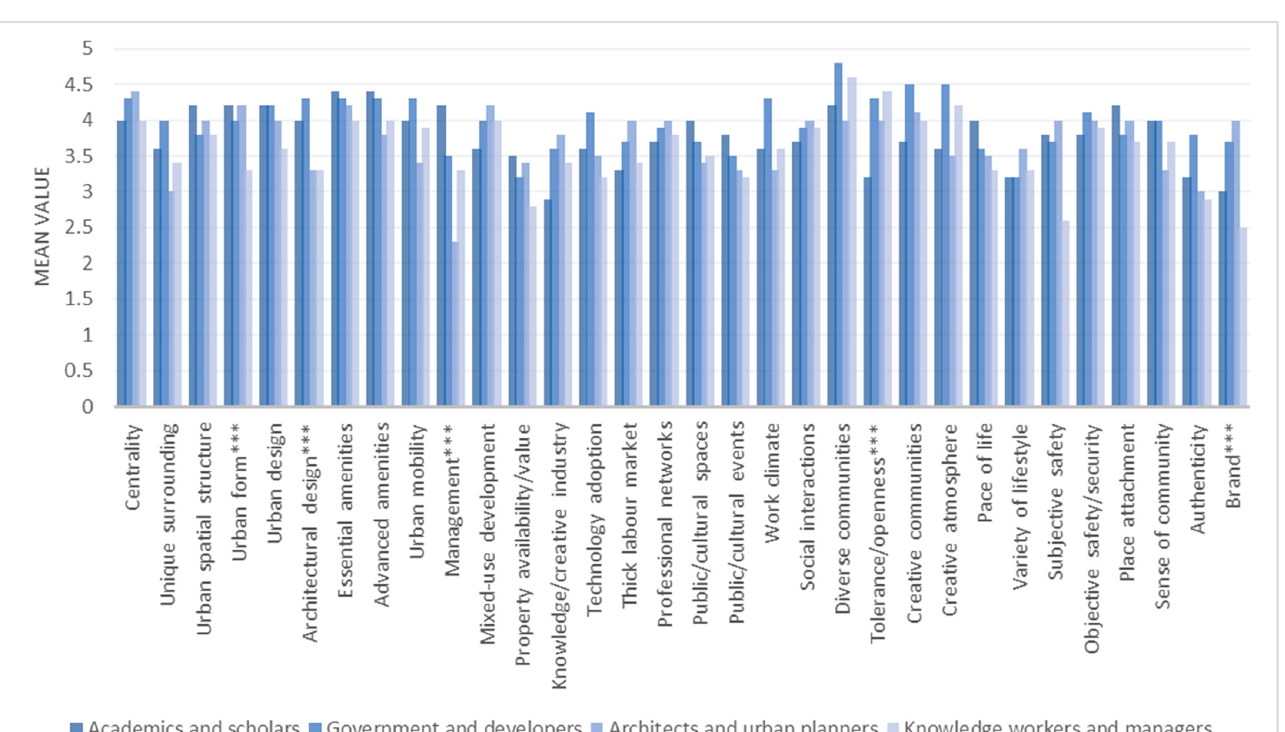
Figure 1. Quantitative evaluation of place characteristics in Kelvin Grove Urban Village.